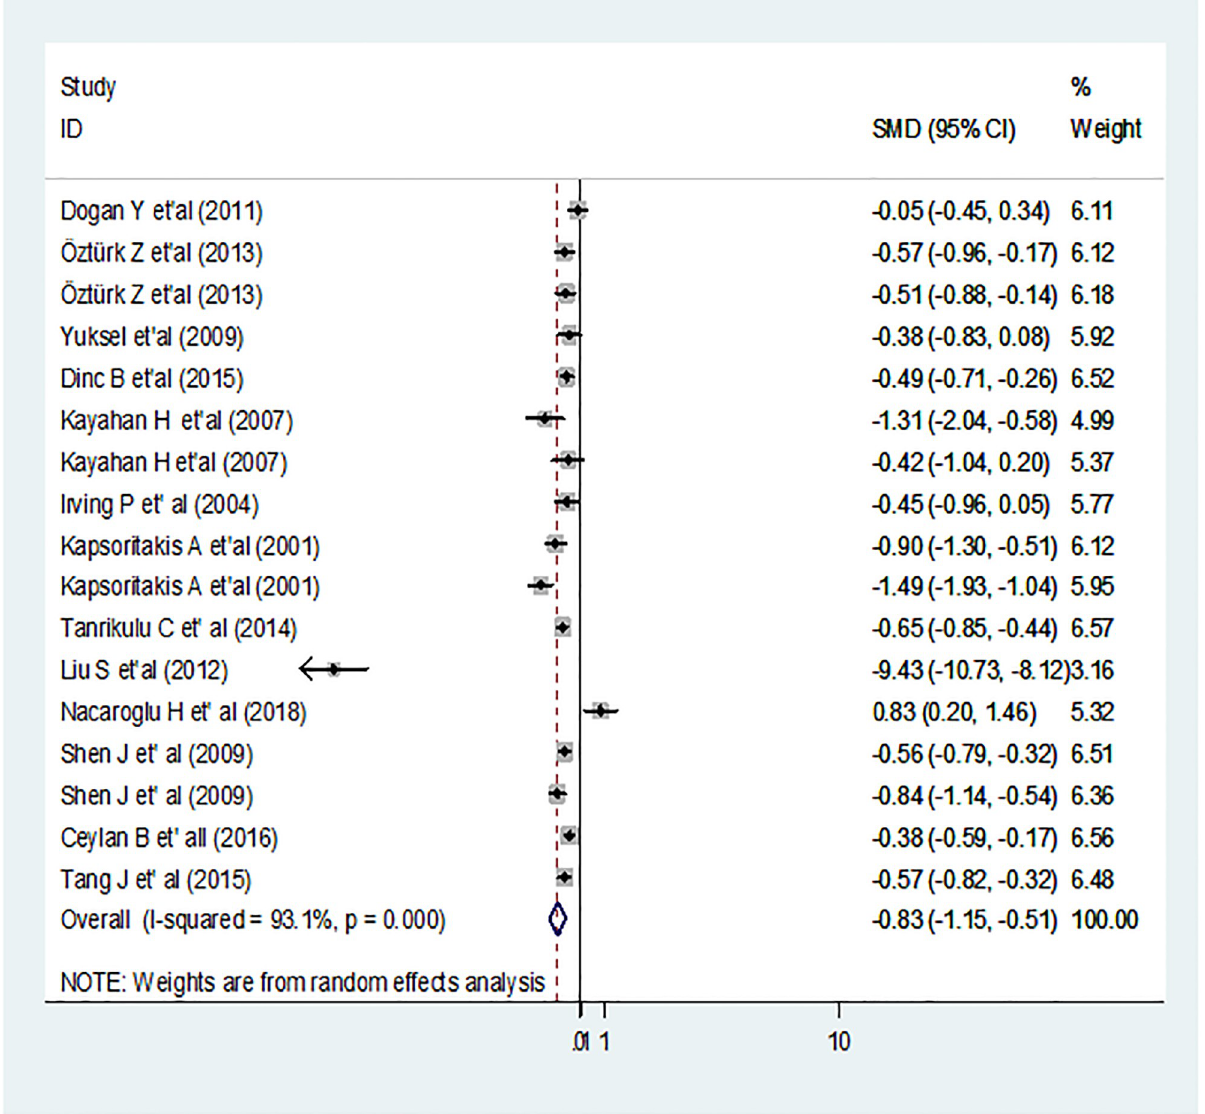
Fig 5. Forest plot of pooled estimated SMD using random effect model. The size of the x-axis shows the SMD estimate of the studies. Hard line indicates no difference (SMD = 0). In the pooled point calculation, the dotted line represents the mean difference. The black dot in the middle of the gray box reflects the SMD estimate of each sample’s point and the line shows the 95% CI of the estimates. The gray boxes represent each study weight that contributes to the estimation of the pooled mean difference. I-squared illustrates the heterogeneity between the included